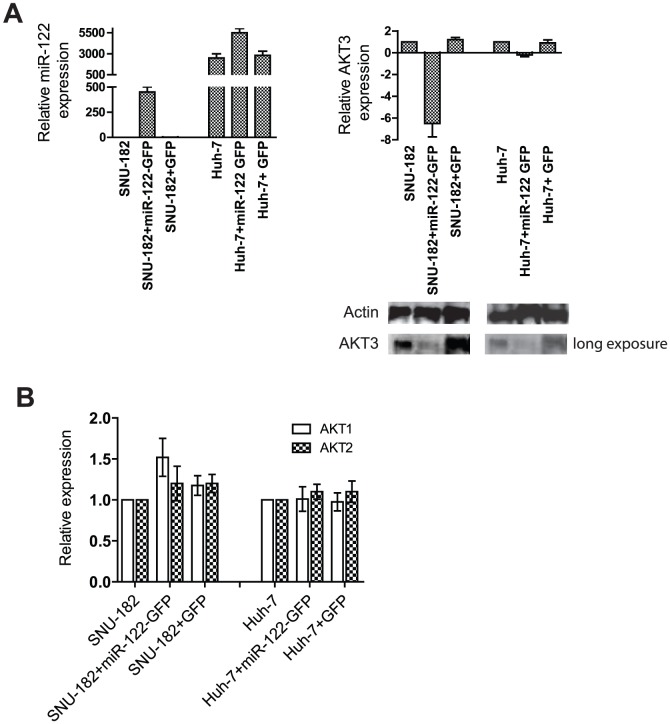
Restoring miR-122 expression decreased AKT3 translation.(A) AKT3 mRNA and protein levels were measured in SNU-182 and Huh-7 cells stably over-expressing miR-122-GFP or GFP alone. The membrane blot of the Huh-7 cells required unusually long exposures before the AKT3 bands could be visualized. (B) AKT1 and AKT2 transcript levels were measured in SNU-182 and Huh-7 cells stably over-expressing miR-122-GFP or GFP alone.